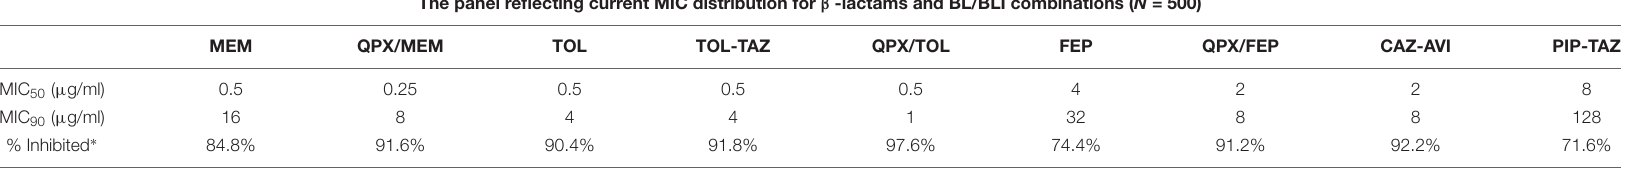
TABLE 7 | In vitro potency of various antibiotics alone and in combination with QPX7728 at 8 µ g/ml and comparator agents against representative and challenge panels of clinical isolates of Pseudomonas aeruginosa . The panel reflecting current MIC distribution for β -lactams and BL/BLI combinations ( N =